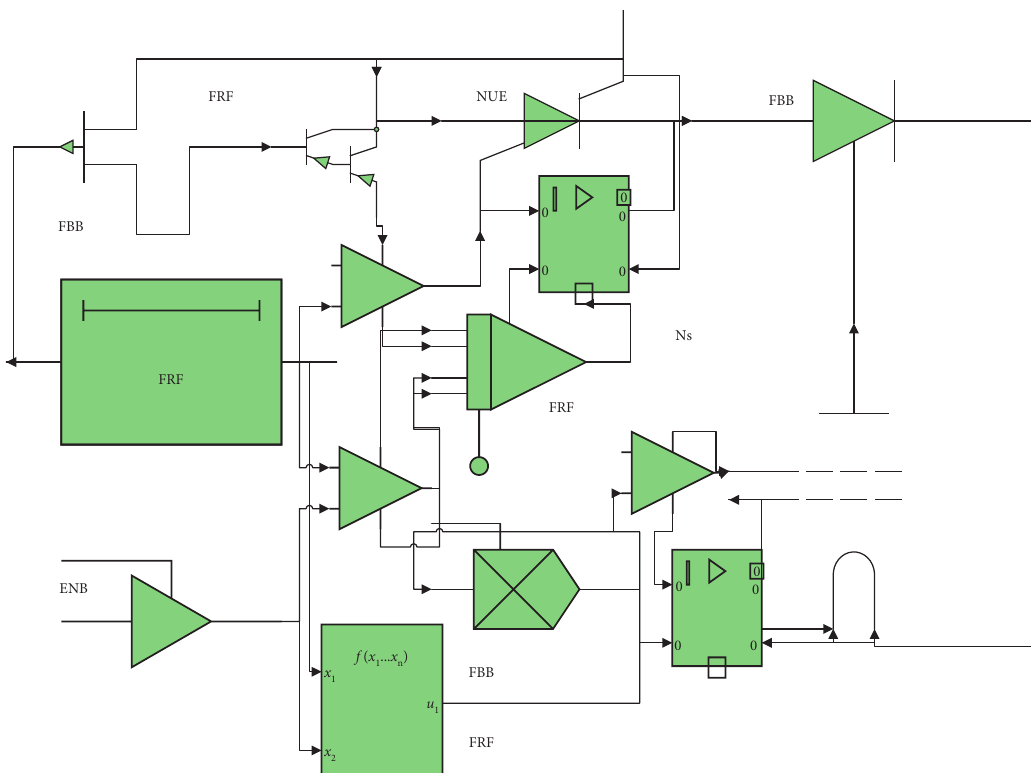
Figure 1: The hardware circuit diagram in the transmission model of the MIMO